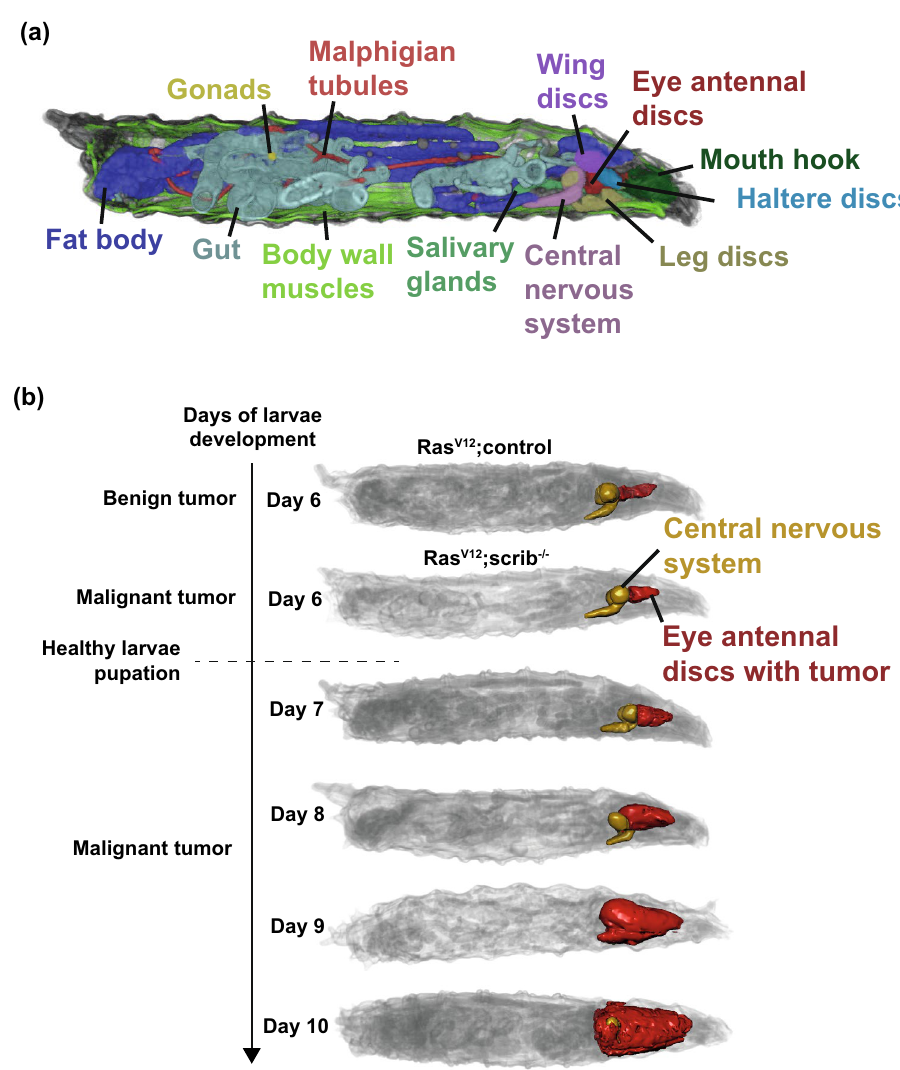
Figure 1. Segmentation and quantification of organs in a D. melanogaster tumor model. ( a ) The main organs of the larvae indicated in different colors. ( b ) An illustration of the brain and eye antennal discs (EAD) where the tumor is growing in Ras V12 ;control and Ras V12 ;scrib −/− larvae at several time-points. Ras V12 ,scrib −/− larvae have an exponentially growing tumor in the EAD that becomes visible around day 6. In healthy larvae, pupation starts around day 6, but when there is a tumor, pupation is delayed. Quantification of EAD volumes of these larvae were reported in Khezri et al. 8 . Shown images are of representative individual